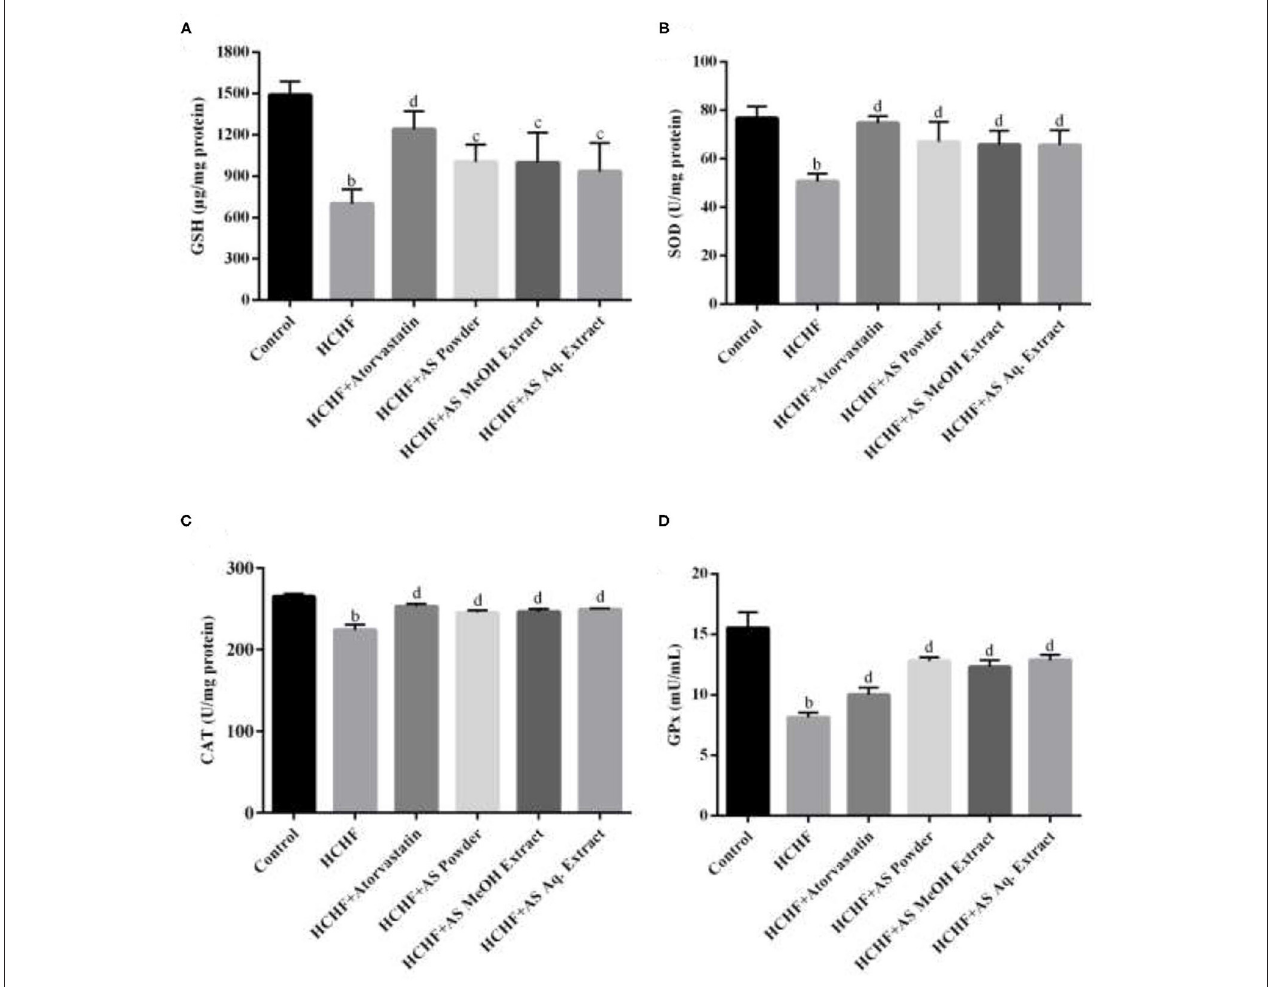
FIGURE 5 | Effect of Amaranthus spinosus on liver tissue (A) reduced glutathione (GSH) level, (B) superoxide dismutase (SOD) activity, (C) catalase (CAT) activity, and (D) glutathione peroxidase (GPx) enzyme level of HCHF diet-induced obese rats. Values are presented as mean ± SD, where n = 5. b p < 0.005 vs. control; c p < 0.05; d p < 0.005 vs.